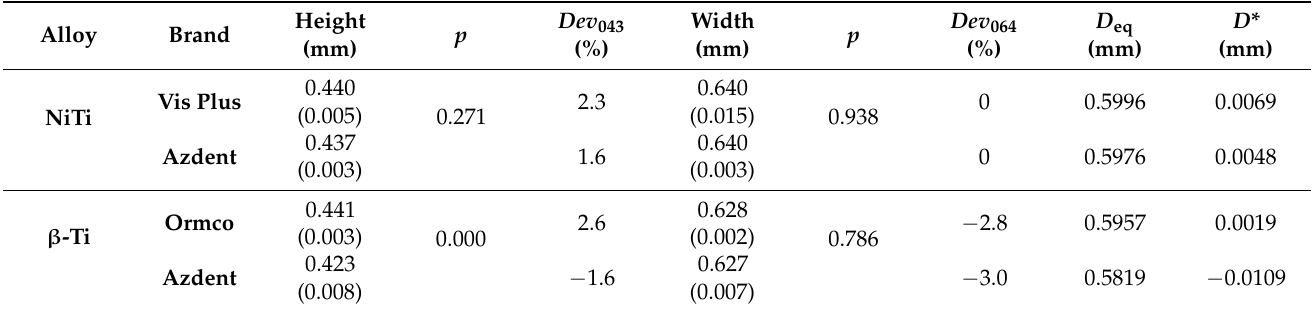
Table 1. Determined mean width and height values (standard deviation) of each product, statistical analysis ( p ), deviation (%) from the manufacturer stated value Dev 043 and Dev 064 , equivalent diameter √ D eq calculated as 1.13 A ( A is cross-sectional area of non-round wire) specified by ANSI/ADA No. 32 and difference from manufacturers’ stated value D* , grouped by alloy